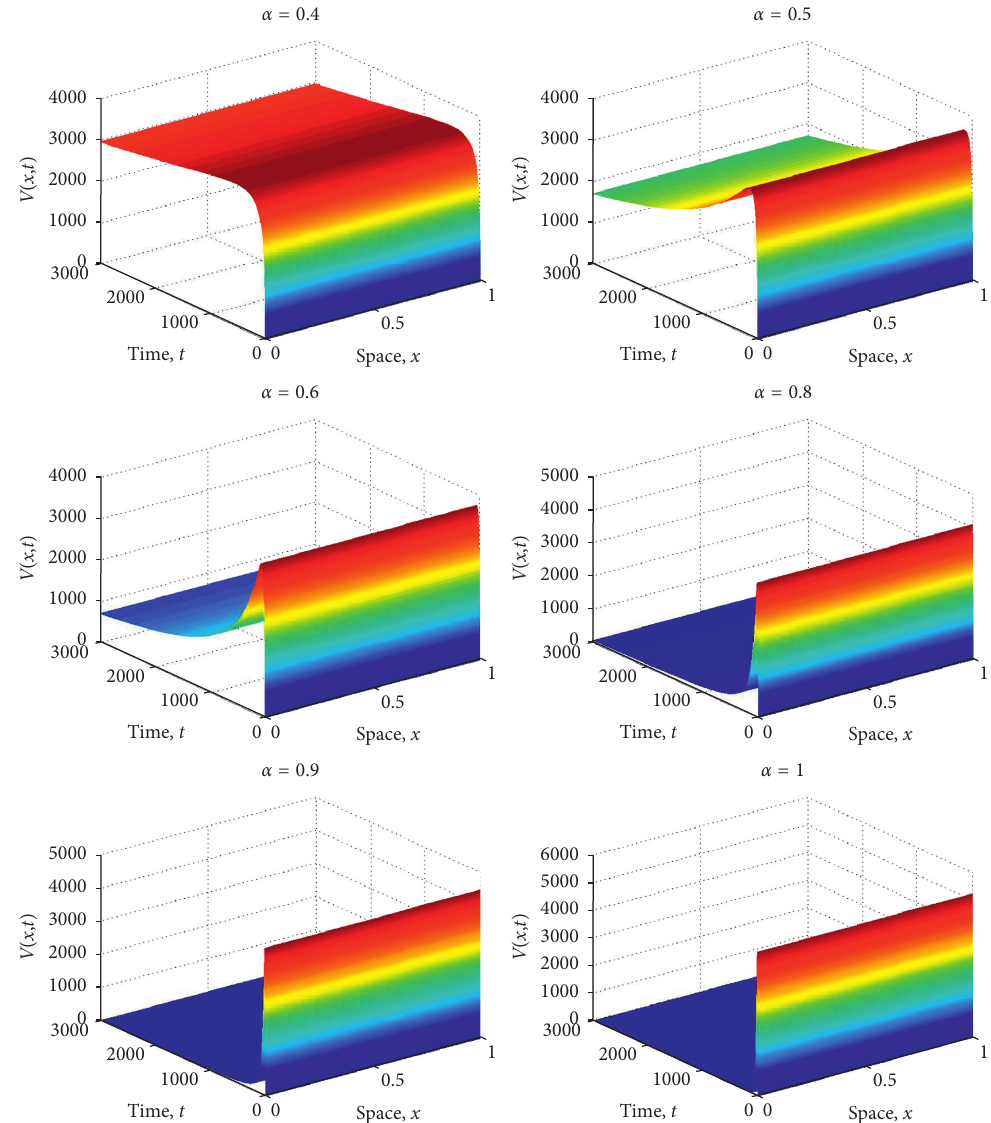
Figure 3: The state variable V ( x, t ) with different values of α